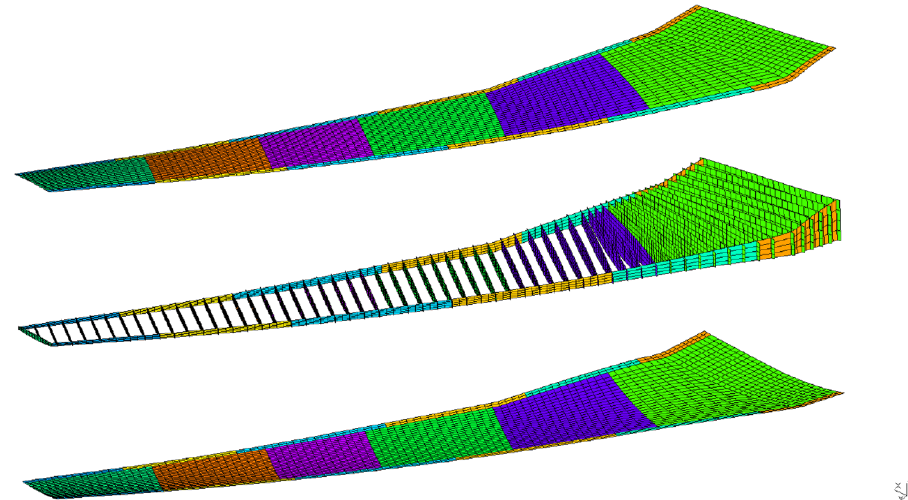
Fig. 2. The finite element model of the CRM wingbox consists of 12475 shell elements, 14134 bar elements, and 10804 nodes.